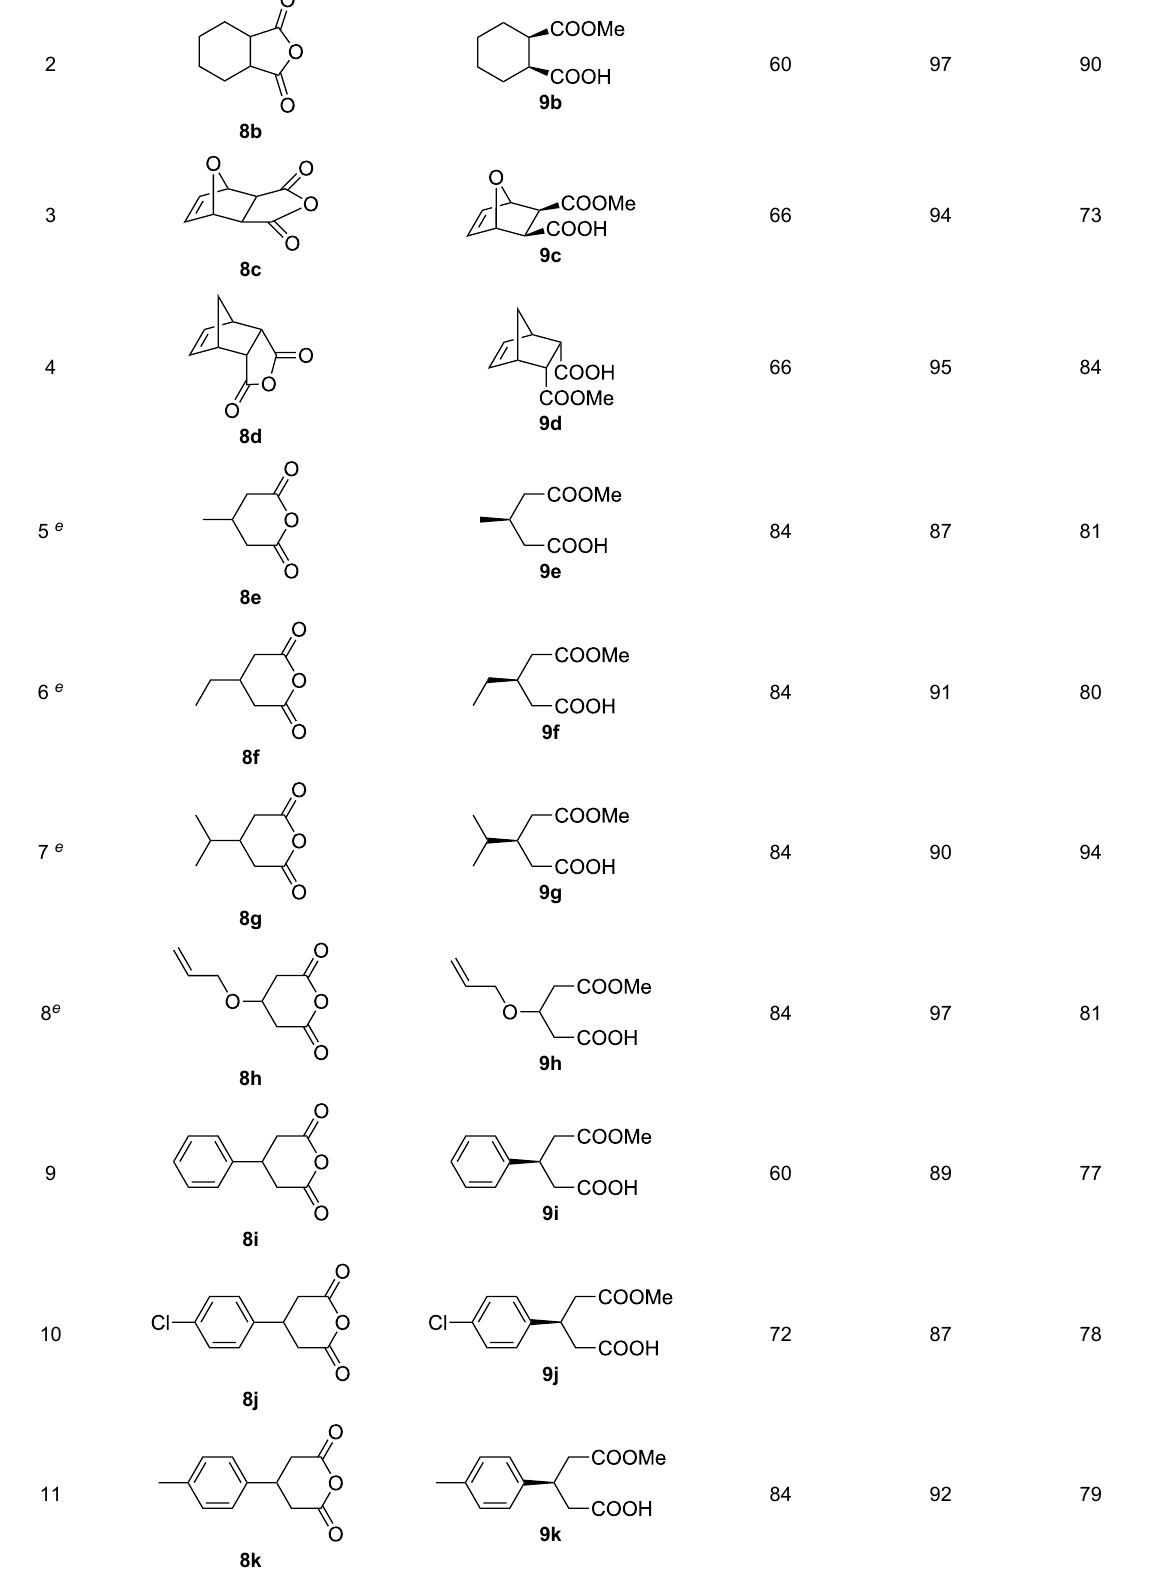
Table 2: Asymmetric methanolysis of meso -cyclic anhydrides. a,b . (continued)